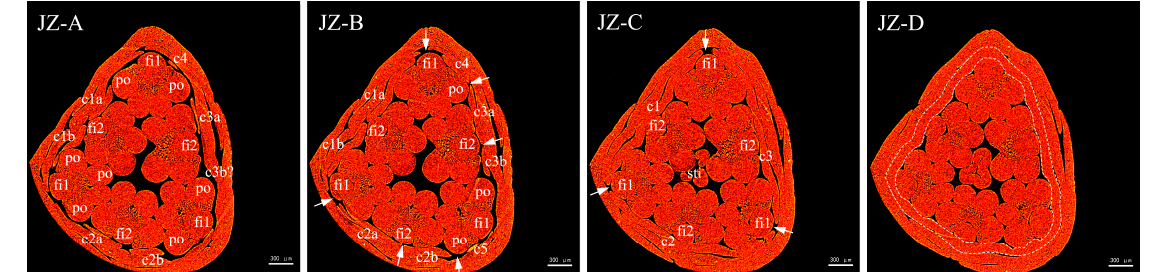
Figure 7. X-ray cross-sectional tomographic images of morphology of the JZ corona. JZ-A to JZ-D are cross-sections in order from top to bottom with the spacings of 25 × 2.1 μ m, 64 × 2.1 μ m, and 35 × 2.1 μ m, respectively, where c1a, c1b, c1, c4, and the like denote corona primordia, fi1 and fi2 stand for filaments of the first and second whorls of stamens, respectively, po represents anther locules, and sti denotes stigma. White dashed lines in JZ-D denote corona primordia that formed a complete structure. found in YLL-10. As shown in Figure 8, A − F show the trend of di ff erentiation of YLL co- rona primordia. In YLL-A and YLL-B, the typical Co primordia were first observed in ST2,